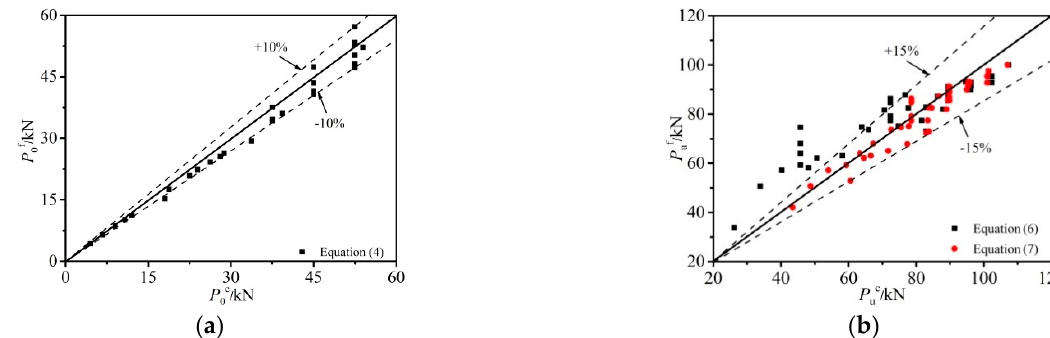
Table 4. Comparison of the shear load and ultimate shear capacities captured by the FE analysis with design recommendations.